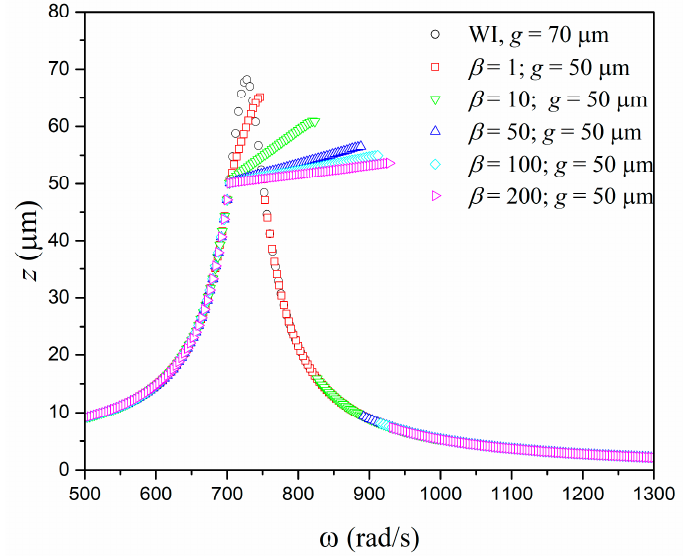
Figure 2. Maximum displacement versus forcing frequency: comparison between linear model without impacts ( g = 70 µ m) and a system incorporating impacts using g = 50 µ m at different values of β.